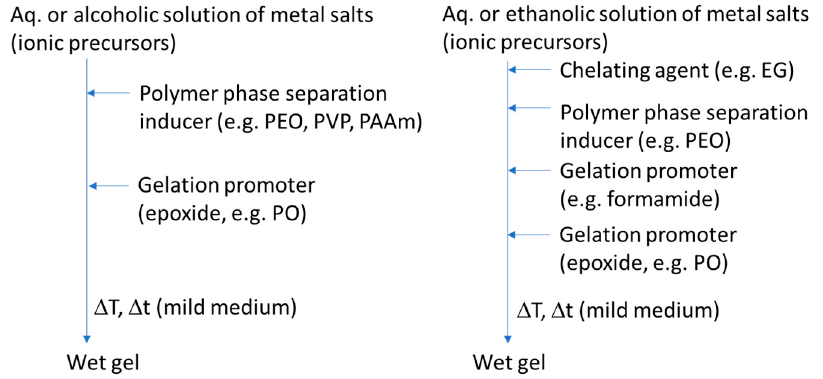
Figure 16. Representative synthesis schemes, showing specific variations, where metal salts (ionic precursors) are employed for the achievement of macroporous monoliths of non-siliceous single- and multi-oxide compositions, based on the epoxide-mediated sol-gel/phase separation method (Marques et al., original schemes).